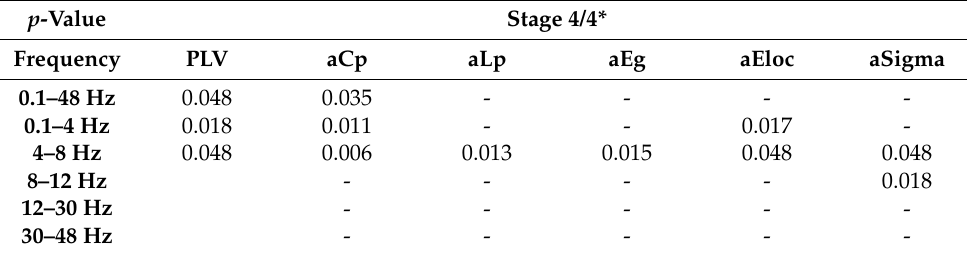
Table 3. Between-group comparisons of weighted brain network